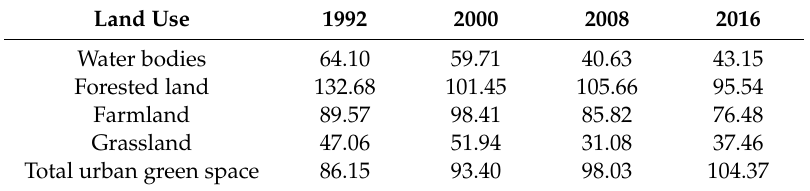
Table 4. Landscape shape index values of green spaces in central Beijing during the period 1992–2016.